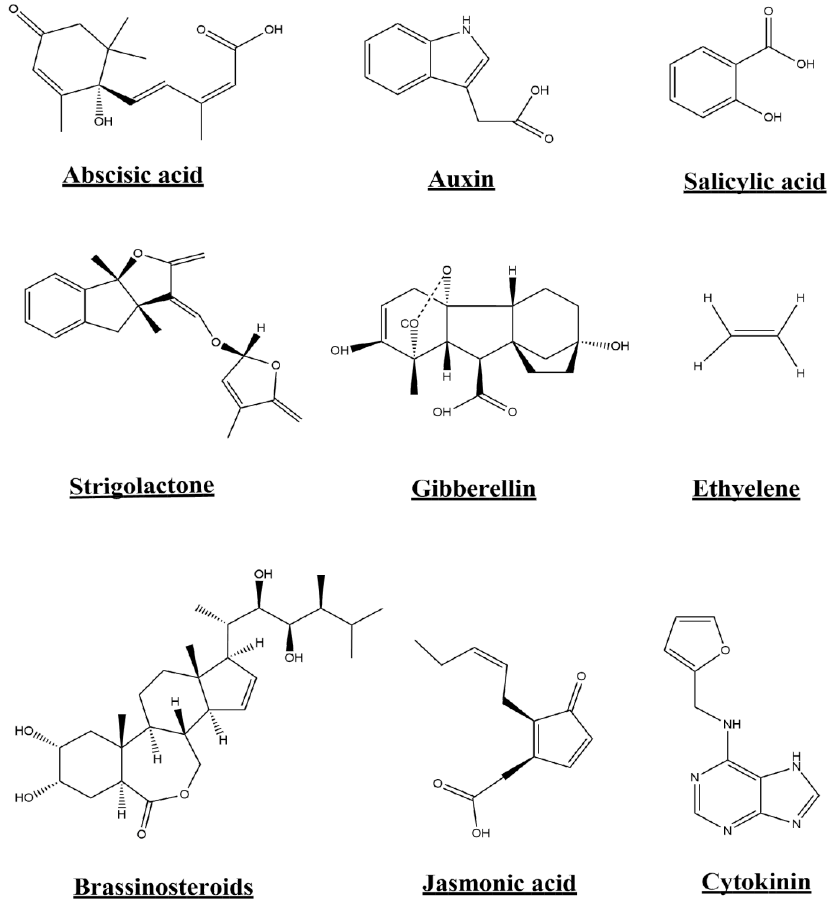
Figure 4. Chemical structures of different classes of stress regulating phytohormes that endophytes could possibly produces, under stresses conditions to enhance host plants growth and deployment.